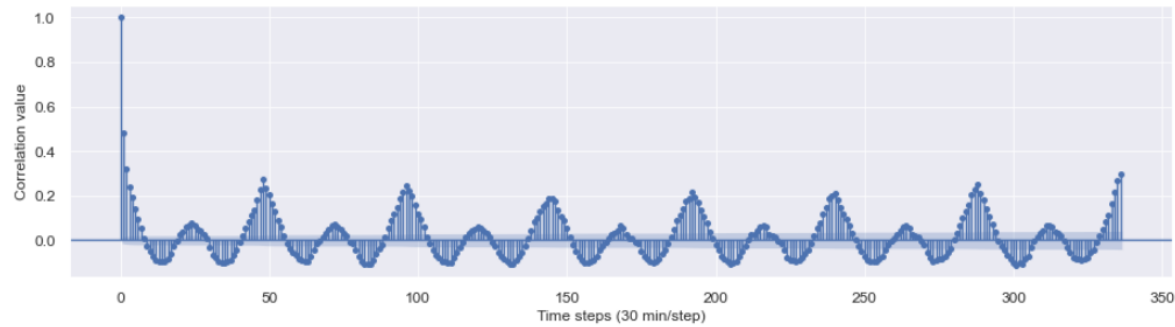
Figure 3. Auto-correlation plot of Energy Consumption. Algorithm 3: C USTOMIZED _F ILLING ( M i , A , M